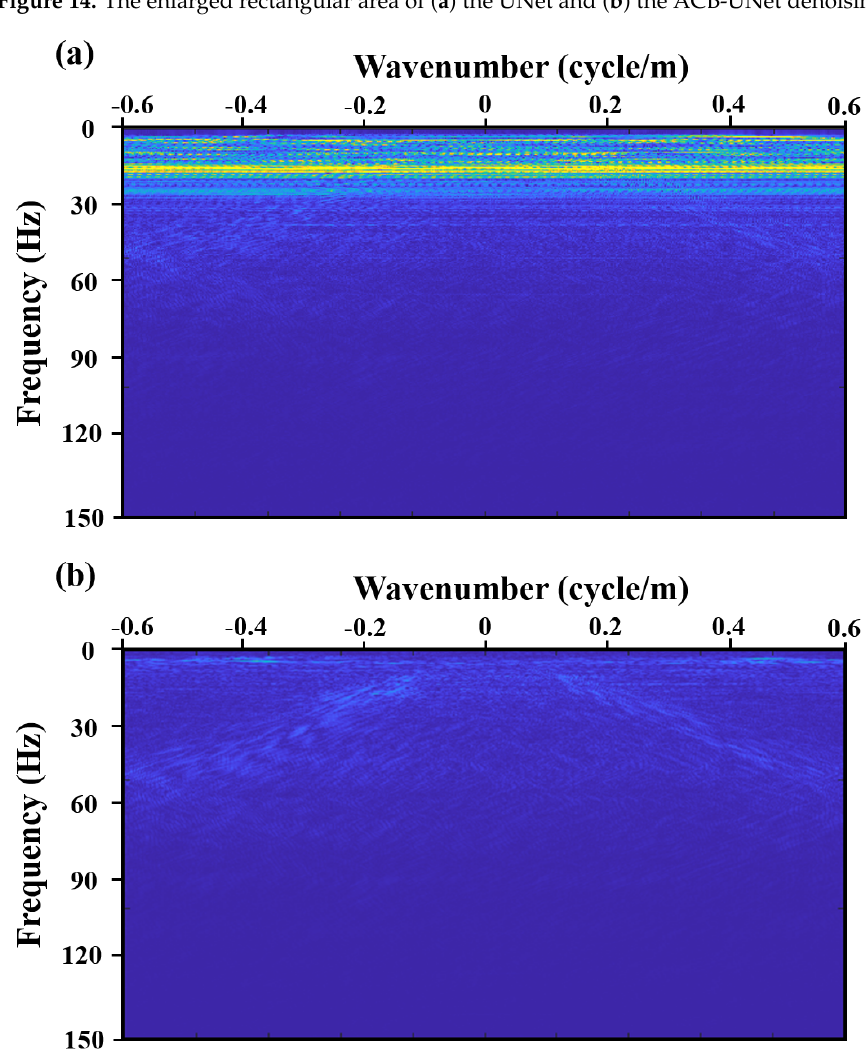
Figure 15. ( a ) The f-k sepectrum of original data; ( b ) the f-k sepectrum of the ACB-UNet de- noised